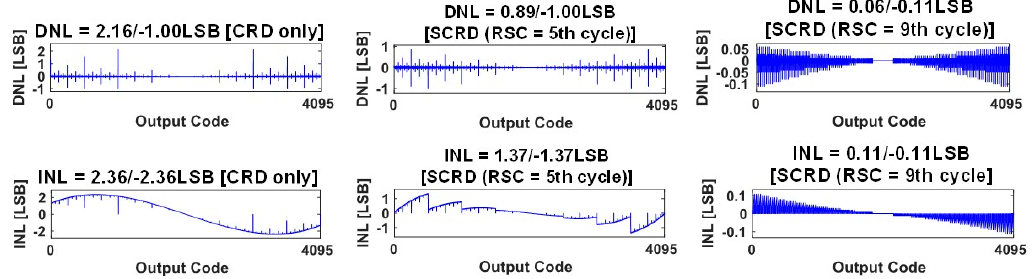
Figure 7. DNL and INL of a behavioral simulation for a 12-bit SAR ADC according to C REF and the RSC.